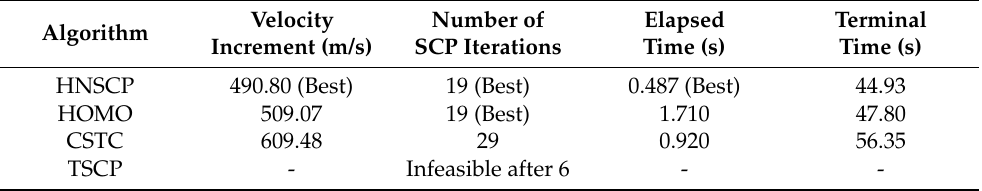
Table 6. Comparison between different SCP-based algorithms ( N =